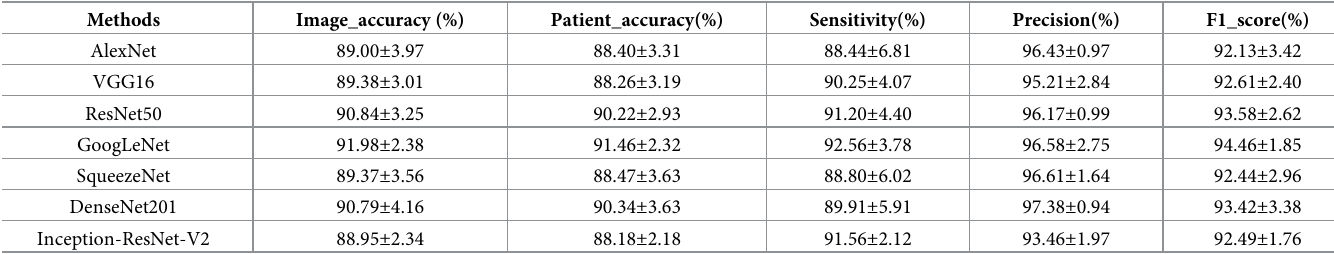
Table 6. MIB classification performance of baseline